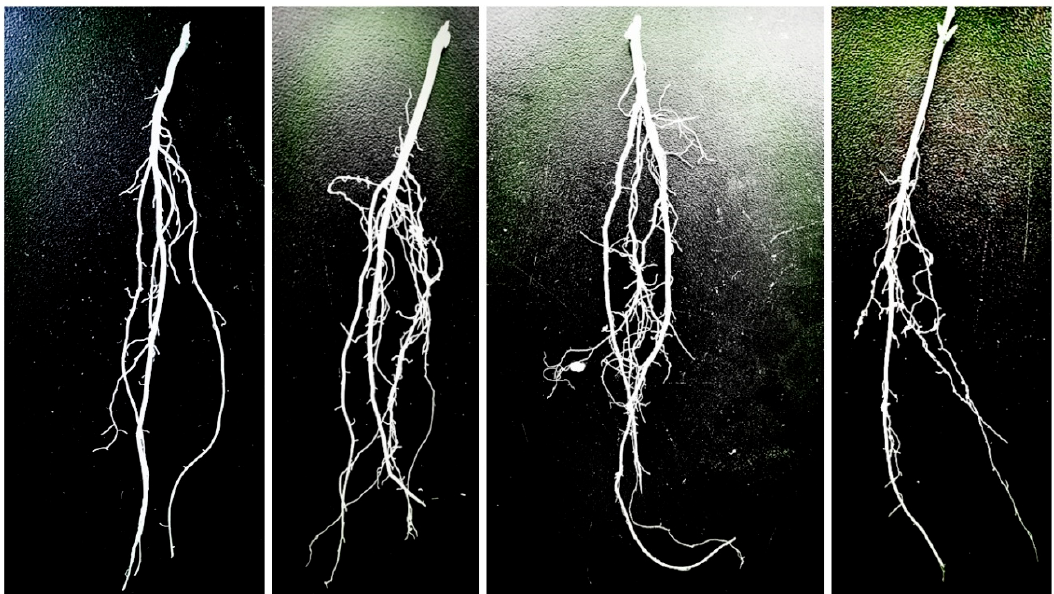
Figure 3. Photographs of the root system of the biofertilizer gradient. Note: The photos are A1, A2, A3, and A4 from left to right.